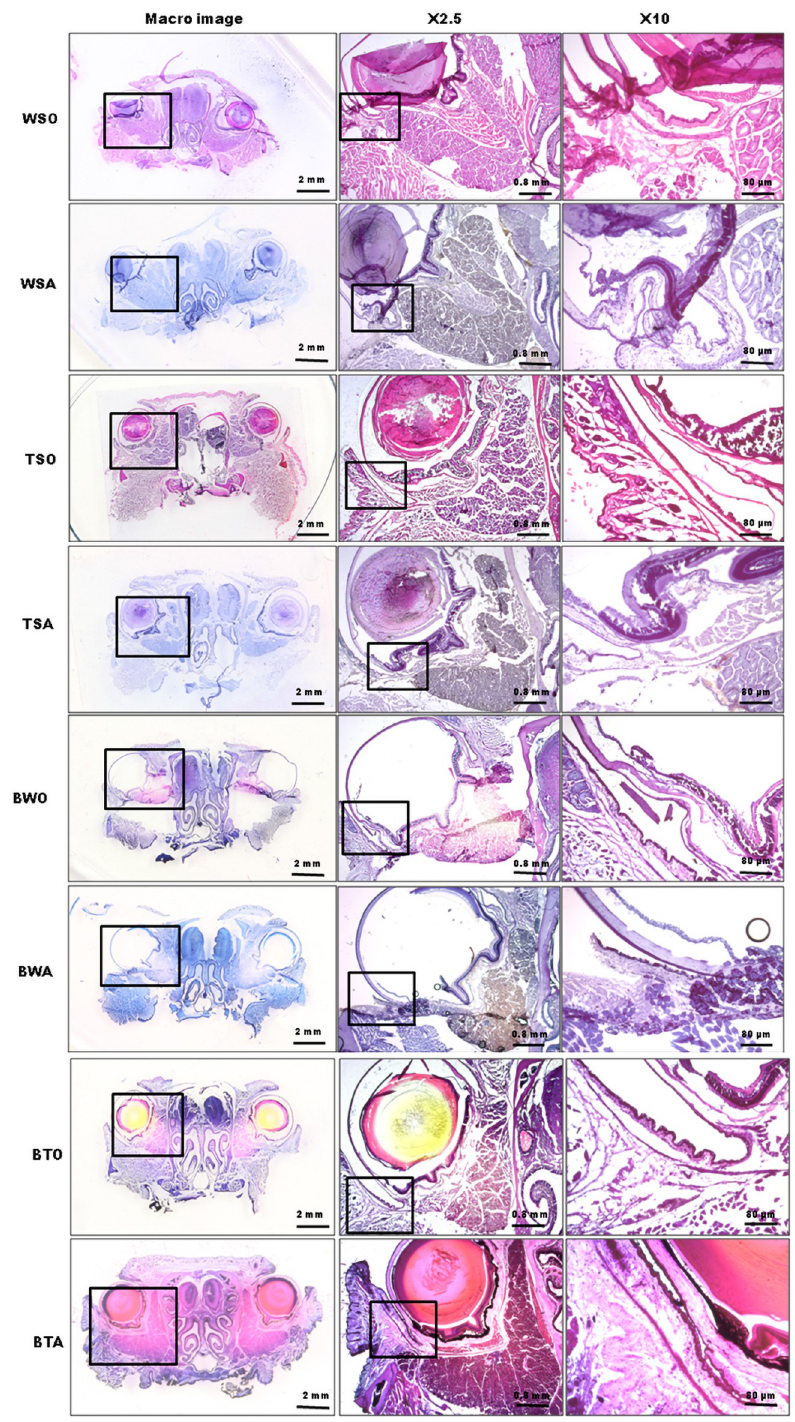
Fig 5. List of representative images of 8 protocols. The representative best quality orbital and eyeball staining images for each protocol are shown at three objective magnification levels—macro (gross), X2.5, and X10. Images in Panel X10 and Panel X2.5 are the local magnifications in those of Panel X2.5 and Panel Macro respectively.